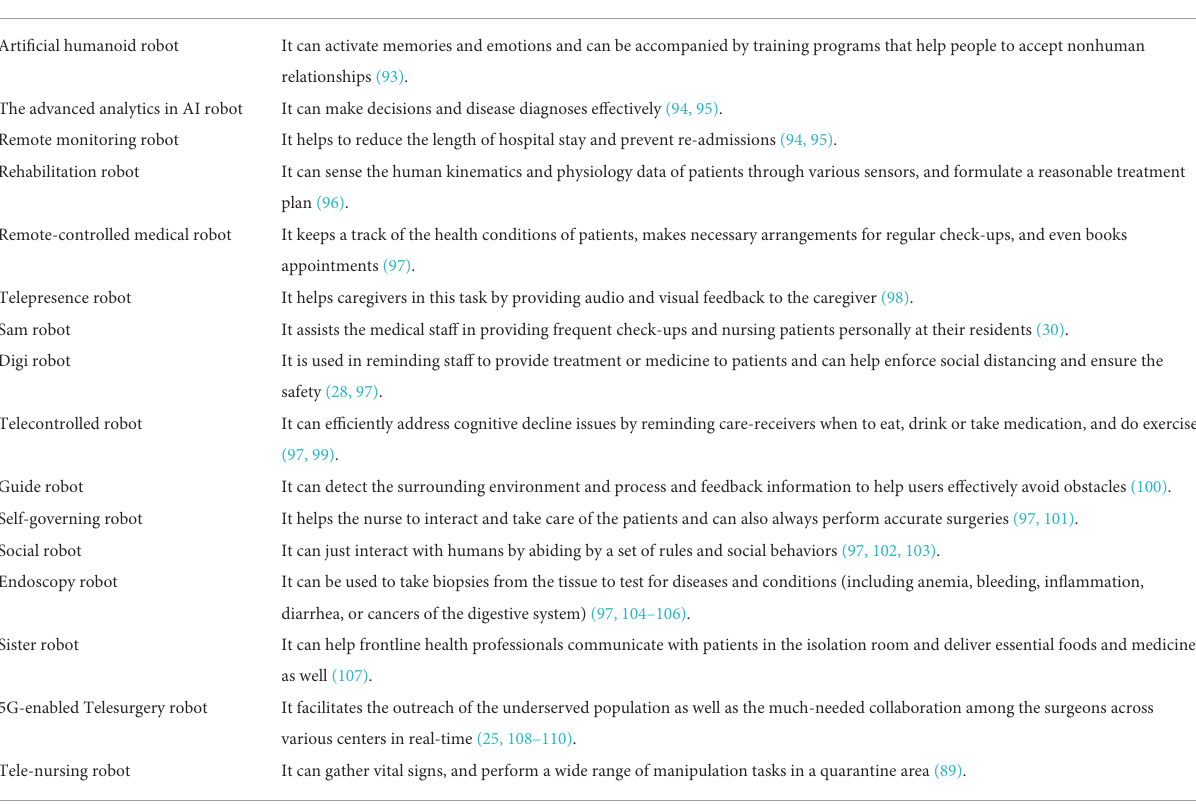
TABLE 3 Smart healthcare with 5G + artificial